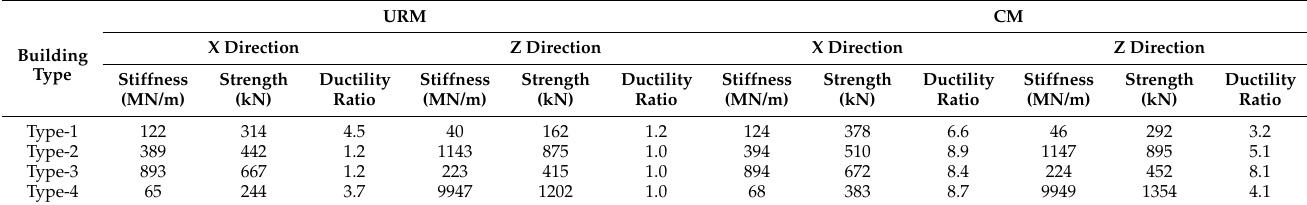
Table 3. Ultimate strength and ductility ratio of model buildings.